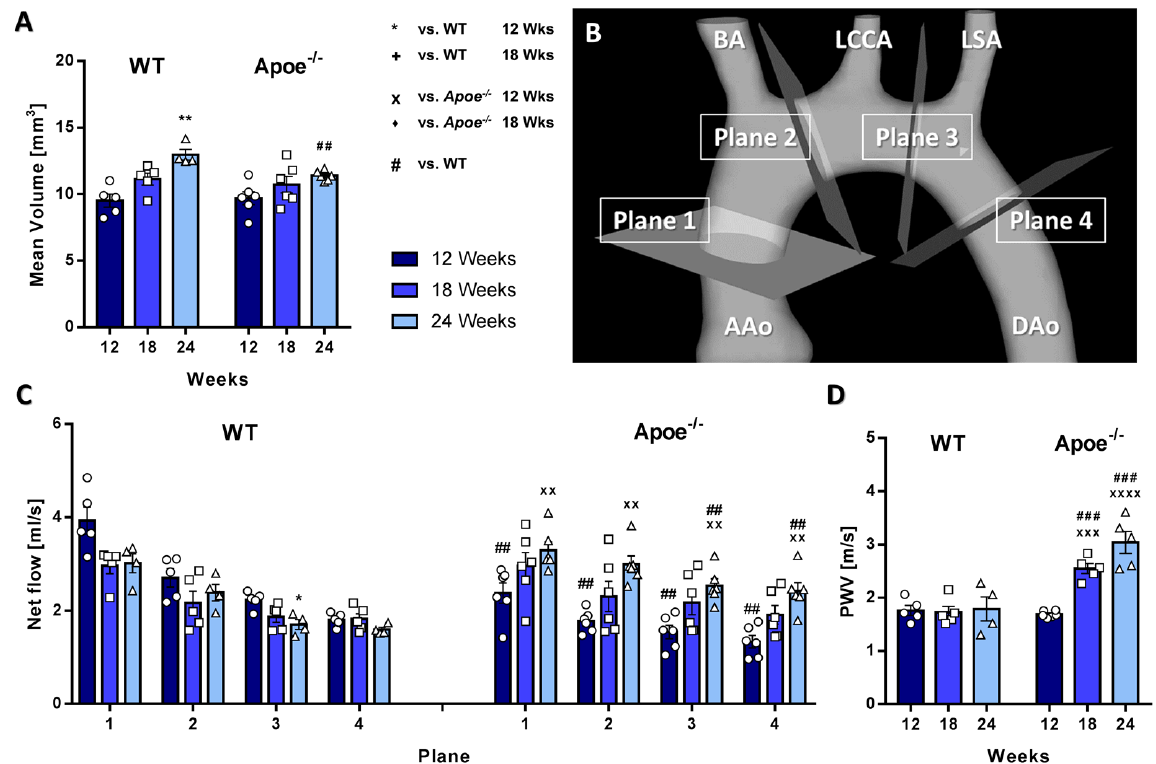
Figure 3. Aortic volumes are decreased and aortic flow and PWV are increased in atherosclerotic Apoe − / − mice. ( A ) Mean aortic volumes were significantly larger in WT compared with Apoe − / − mice at 24 weeks. ( B ) Scheme of the analyzed planes. Plane 1: Inflow into the ascending part of the aortic arch. Plane 2: Residual flow after the BA. Plane 3: Residual flow after the LCCA. Plane 4: Residual flow after the LSA. ( C ) Net flow in the 4 analysis planes. WT mice showed a decrease, whereas Apoe − / − mice showed an increase in net flow over the course of the study. ( D ) PWV values. In contrast to WT mice, Apoe − / − mice displayed an increase in PWV over time. * vs. WT 12 weeks, p < 0.05; ** vs. WT 12 weeks, p < 0.01; + vs. WT 18 weeks, p < 0.05; x vs. Apoe − / − 12 weeks, p < 0.05; xx vs. Apoe − / − 12 weeks, p < 0.01; xxx vs. Apoe − / − 12 weeks, p < 0.001; xxxx vs. Apoe − / − 12 weeks, p < 0.0001; (cid:7) vs. Apoe − / − 18 weeks, p < 0.05; # vs. WT, p < 0.05; ## vs. WT, p < 0.01; ### vs. WT, p < 0.001.